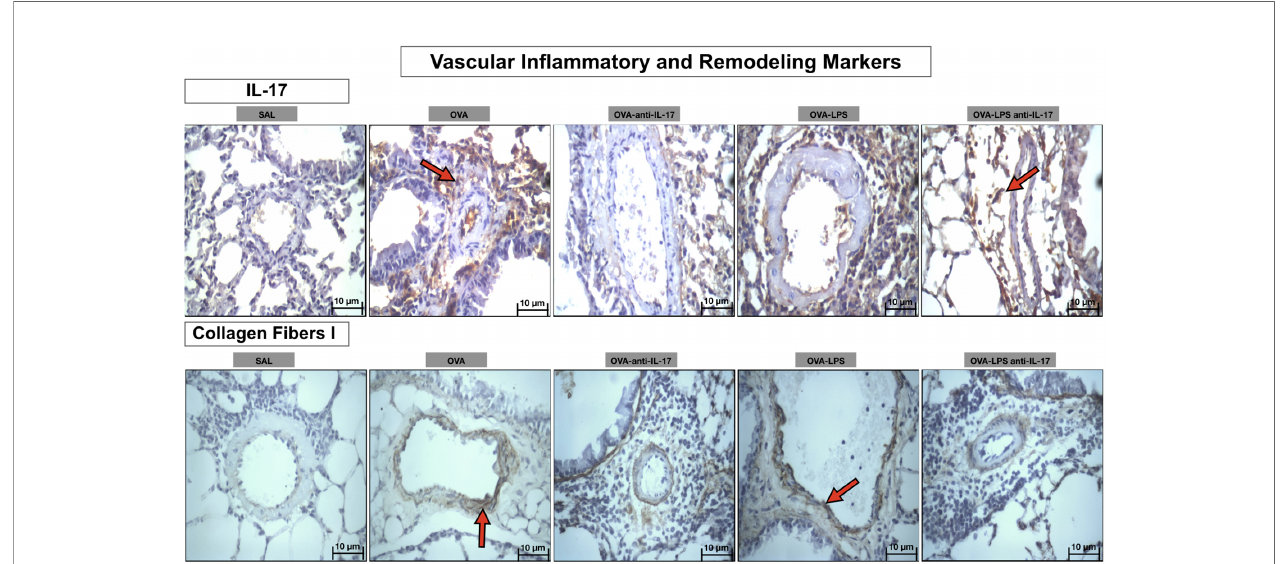
FIGURE 10 | Qualitative analysis of vascular in fl ammation and remodeling. Photomicrographs showing the presence of in fl ammation around the pulmonary vessels. The slides were stained for IL-17 expressing positive cells and collagen fi ber I content. The experimental groups include SAL, OVA, OVA-anti-IL-17, OVA – LPS, and OVA – LPS-anti-IL-17. The red arrows indicate the positive cells for IL-17 and collagen fi ber I content.